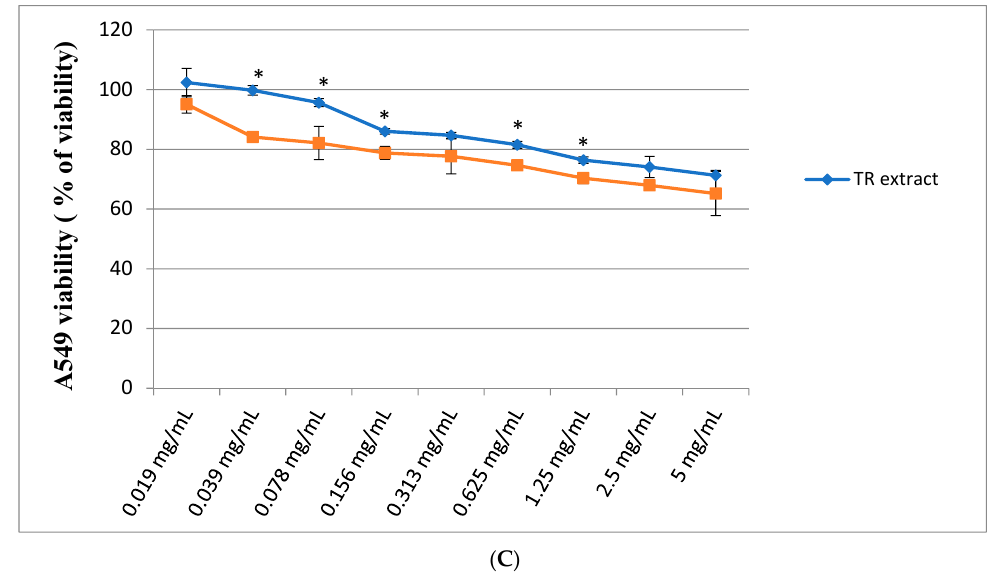
Figure 1. The effect of TR and AtPAP1 TR root extract of L. sibiricus (in concentrations of 0.019–5 mg/mL) on ( A ) CCRF-CEM, ( B ) K562 and ( C ) A549 cells viability. The data represent the mean of 3 measurements. *: p < 0.05 TR vs AtPAP1 TR.